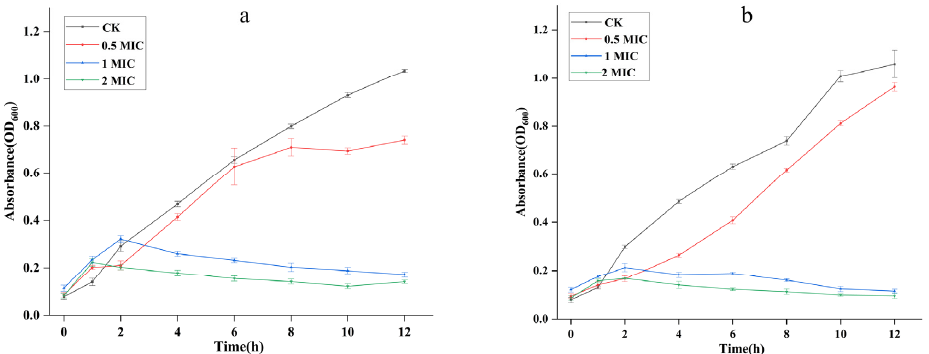
Figure 7. Effect of the AgEo on E. coli ( a ) and S. aureus ( b ) growth.